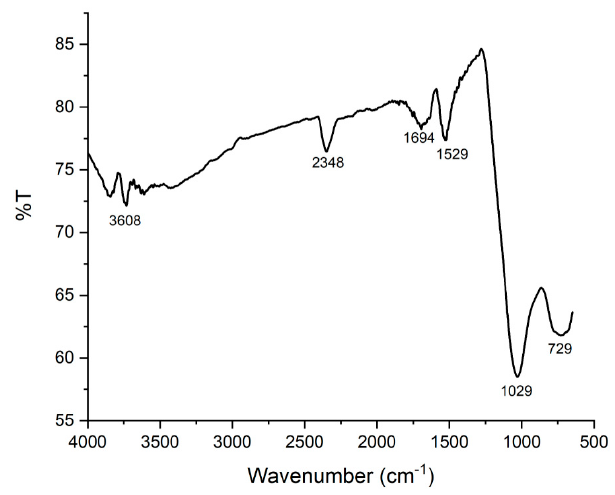
Figure 9. Infrared (IR) spectrum of fly ash.